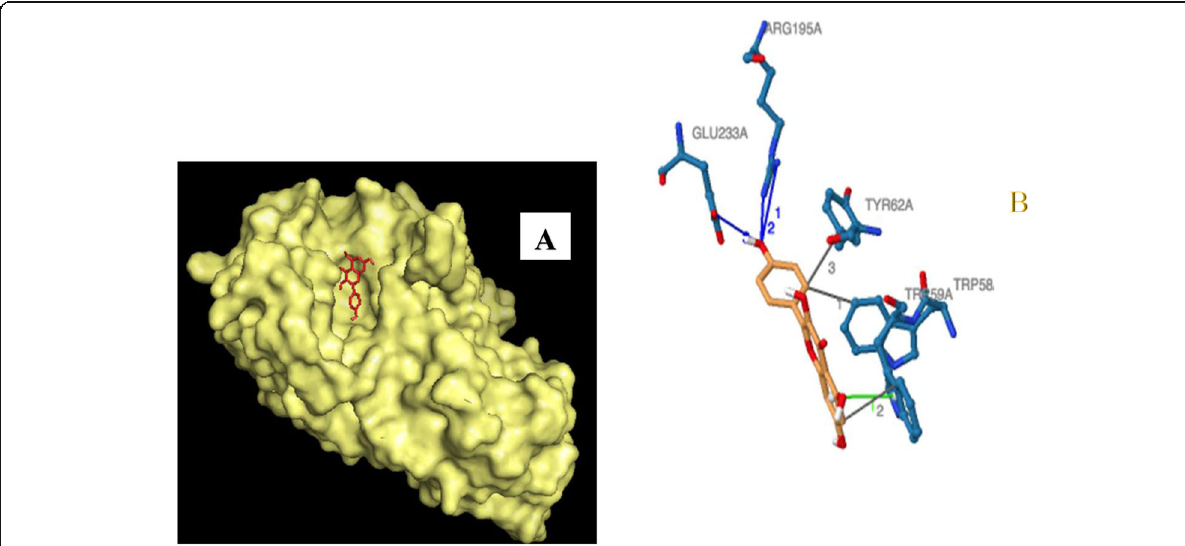
Fig. 11 Binding pose and binding site of kaempferol with α -amylase (panel A), molecular interaction of kaempferol with amino acid residues within the binding pocket of the protein structure (panel B)